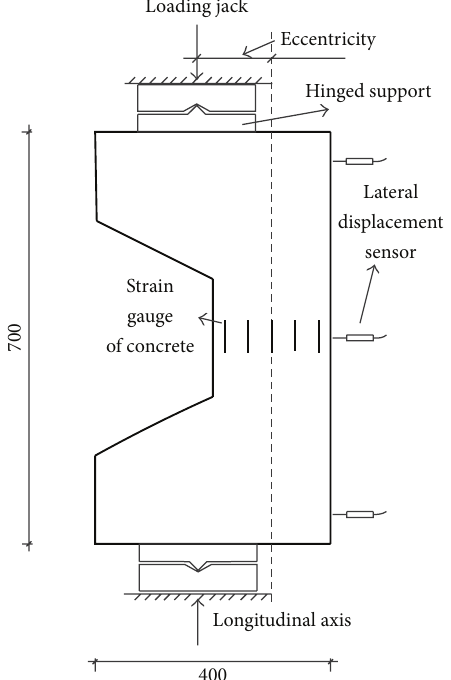
Figure 3: Scheme of static loading test.